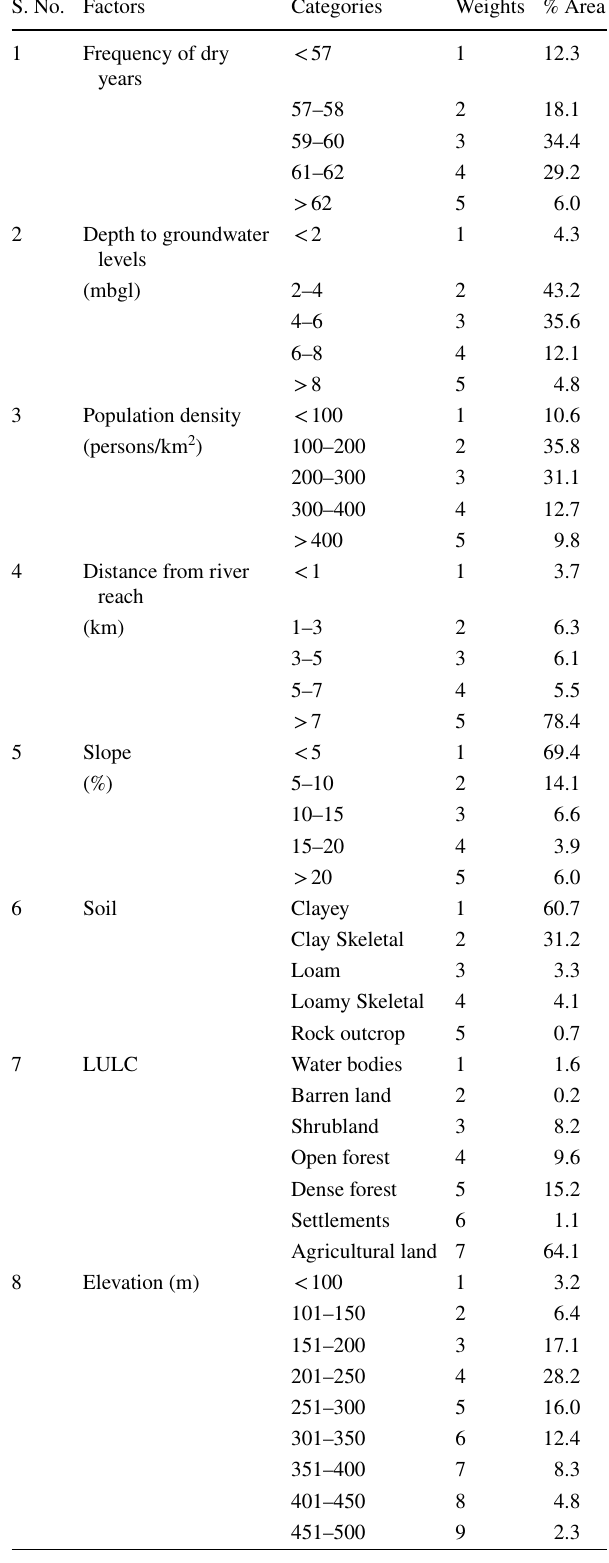
Table 3 Weightage of various factors contributing to drought vulner-